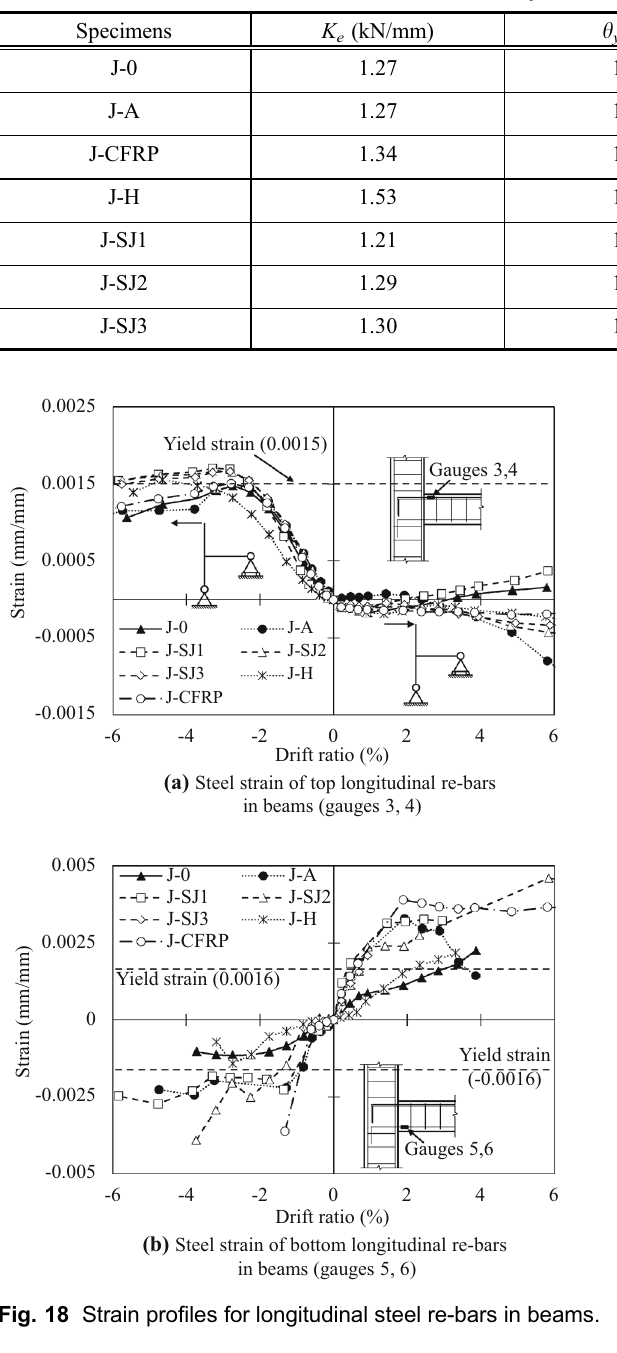
Table 2 Effective stiffness and ductility in a negative loading direction obtained from test results.